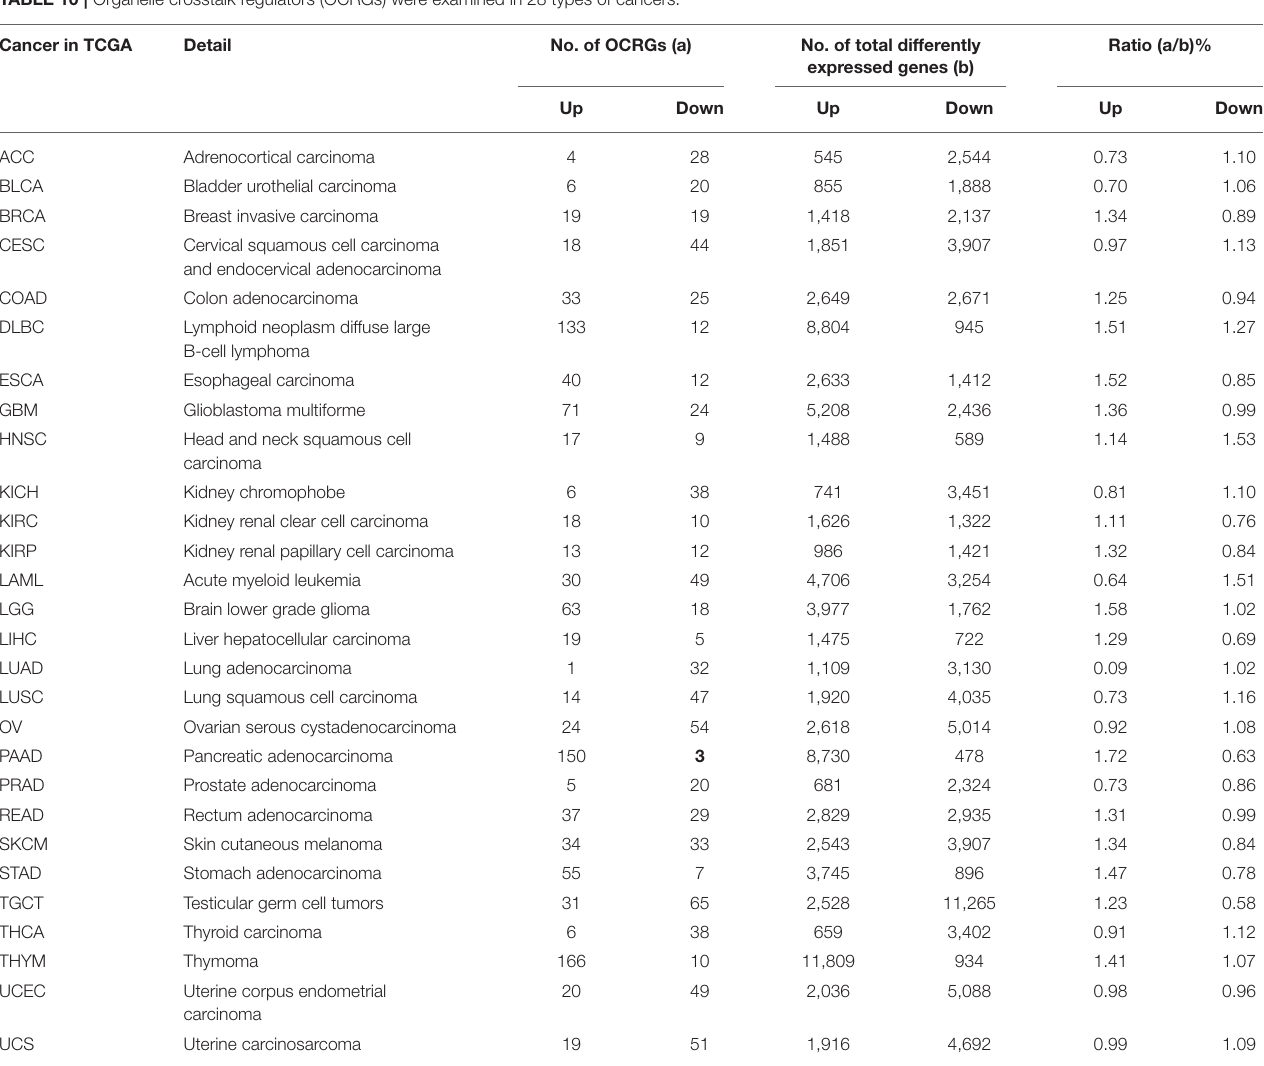
TABLE 10 | Organelle crosstalk regulators (OCRGs) were examined in 28 types of cancers. Cancer in